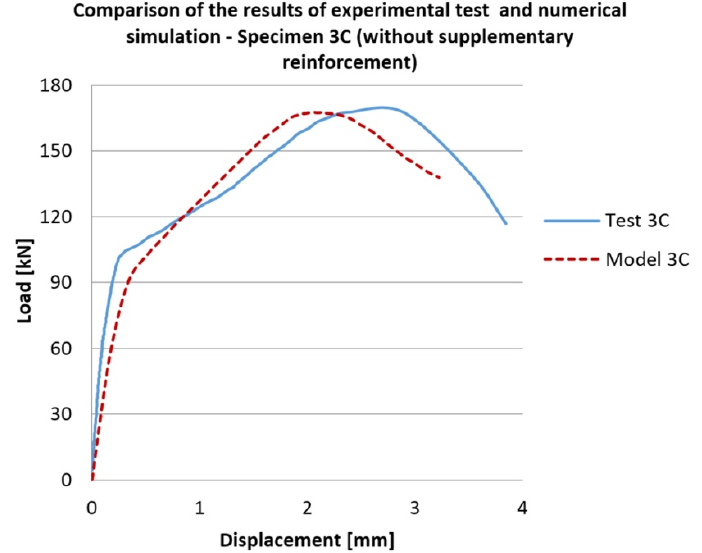
Figure 15. Comparison of results of the experimental test with numerical simulation—specimen without supplementary reinforcement.